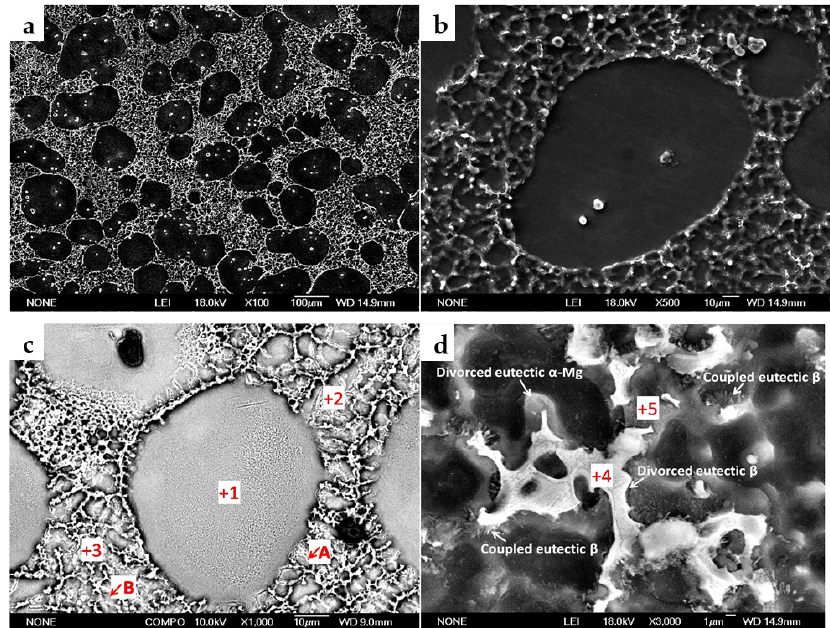
Figure 10. SEM micrographs showing detailed microstructure of the SIRD AM60 sample. ( a ) at lower magnification showing the distribution of primary α -Mg and eutectics; ( b ) at higher magnification and ( c ) back-scattered electron image showing detailed morphology of primary α -Mg; ( d ) at higher magnification showing the eutectic morphology.